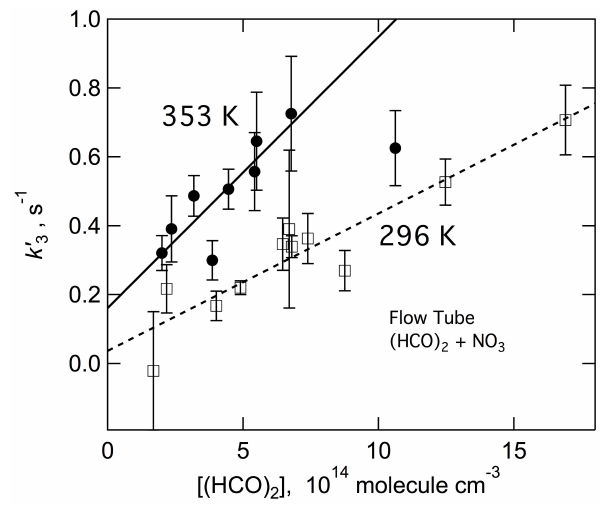
Fig. 6. Relative rate data for the NO 3 + (HCO) 2 (glyoxal) reac- tion at 296K and 650Torr (Syn. Air) with C 2 H 4 and iso-butane as the reference compounds. The solid symbols represents the data obtained in the presence of 1.7 × 10 16 moleculescm − 3 of CF 3 CF=CHF. The lines are linear least-squares fits of the data to Eq. (3), where the uncertainty is 2 σ of the fit